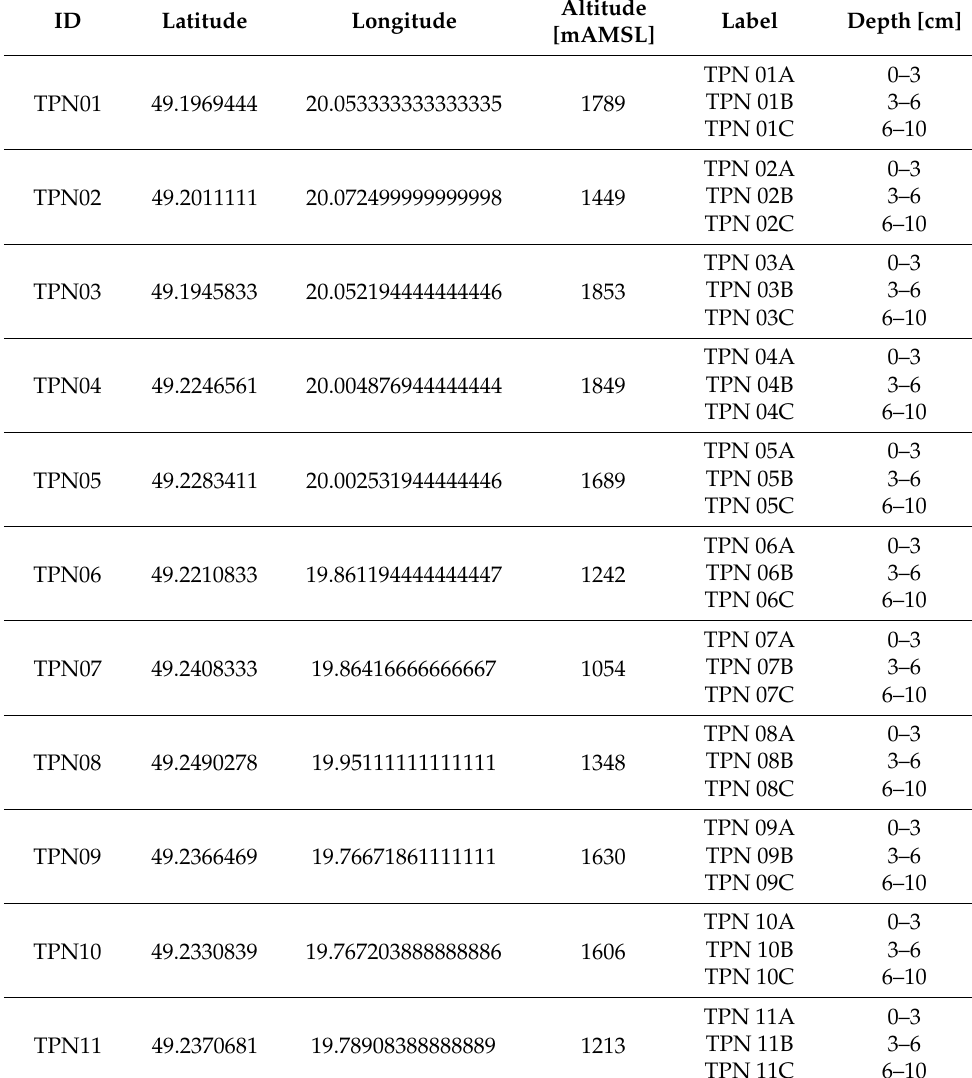
Table 2. The list of soil